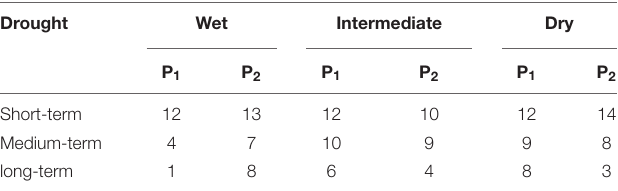
TABLE 2 | The number of the short-term (SPEI-3 < –1), medium-term (SPEI-6 < –1), and long-term (SPEI-12 < –1) droughts event over the wet, intermediate, and dry region of MRB for early period (P 1 ;1985–1999) and late period (P 2 ;